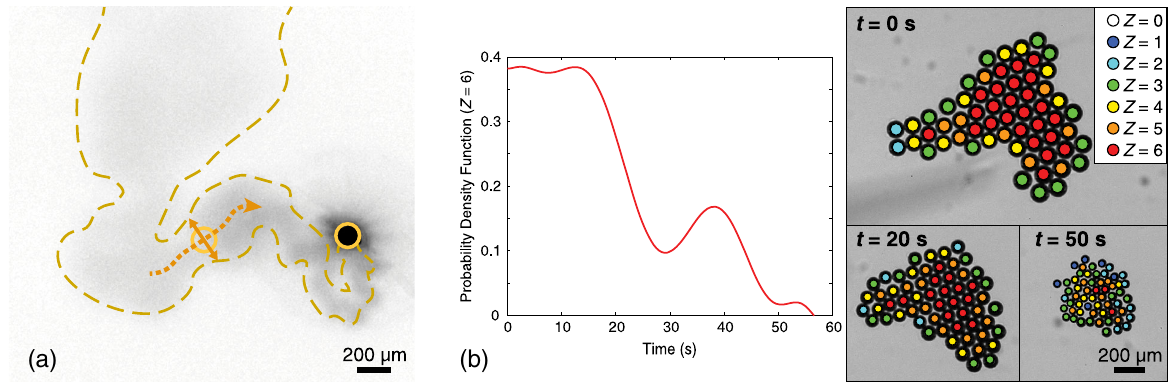
FIG. 9. Memory effects in droplets. (a) Droplets leave a fluorescently labeled trail (dashed lines), which diffusively spreads with a diffusion constant consistent with that of DEP-filled micelles, confirming the proposed mechanism in Fig. 1. (b) Active droplets transition from a crystal to a more dilute, disordered cluster over time. The graph shows the concomitant drop in the coordination number Z ¼ 6 , shown in red in the snapshots from the